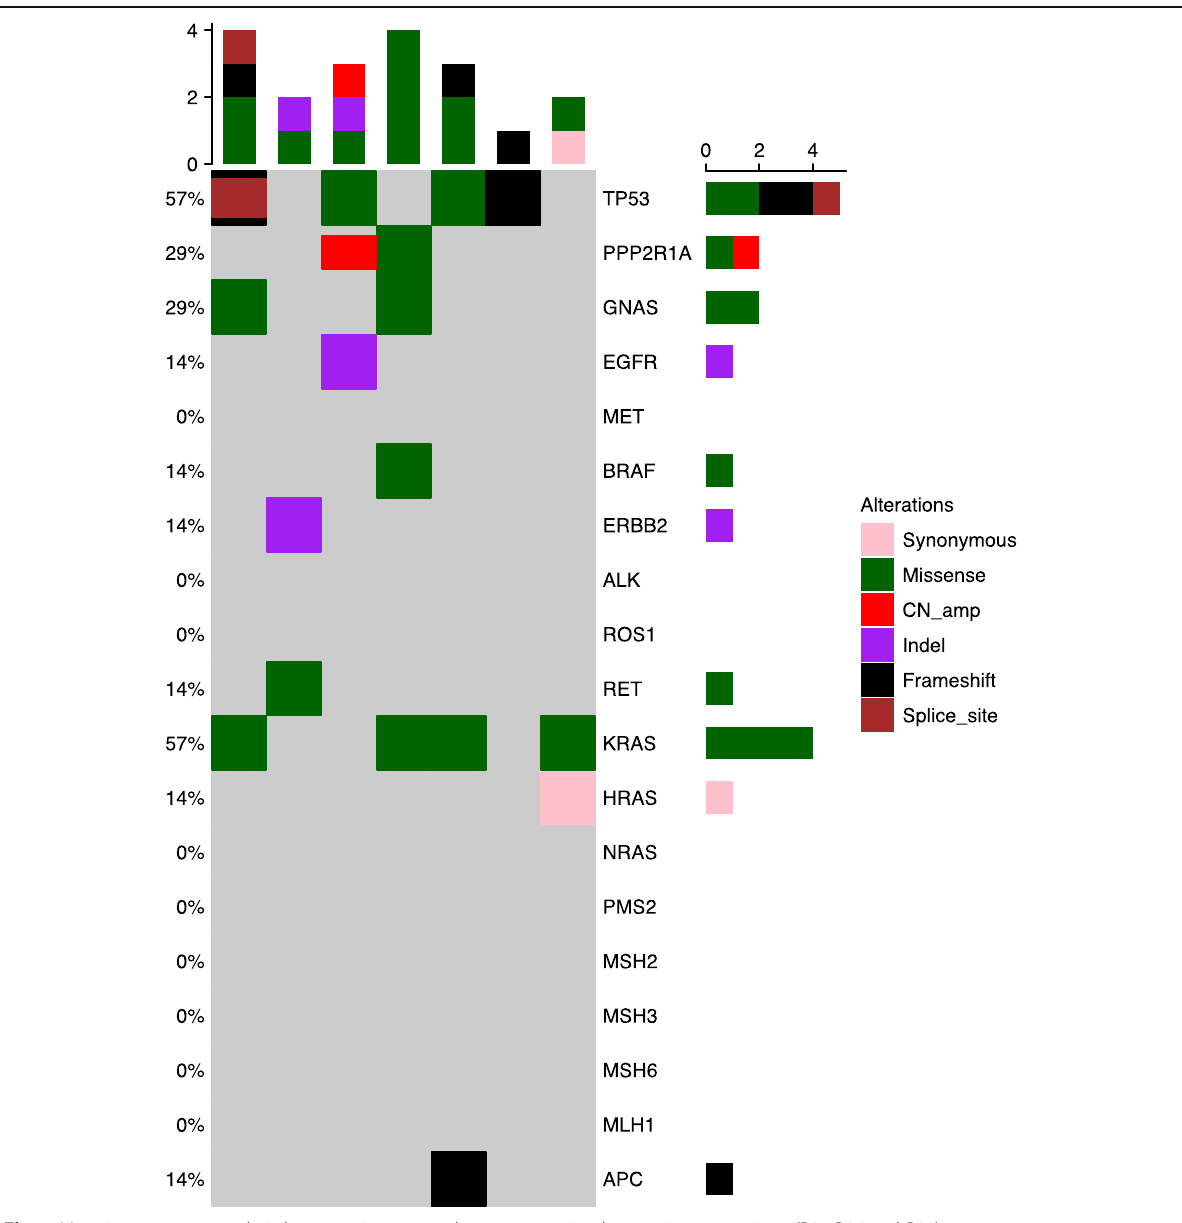
Fig. 1 Mutation spectrum analysis heatmap in seven pulmonary enteric adenocarcinoma patients (P01-P06 and